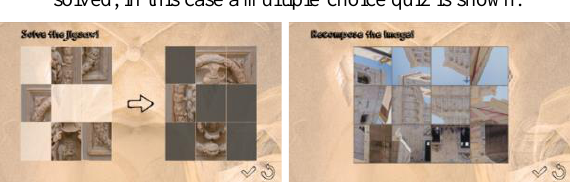
Figure 10 . Some examples of the puzzles in the